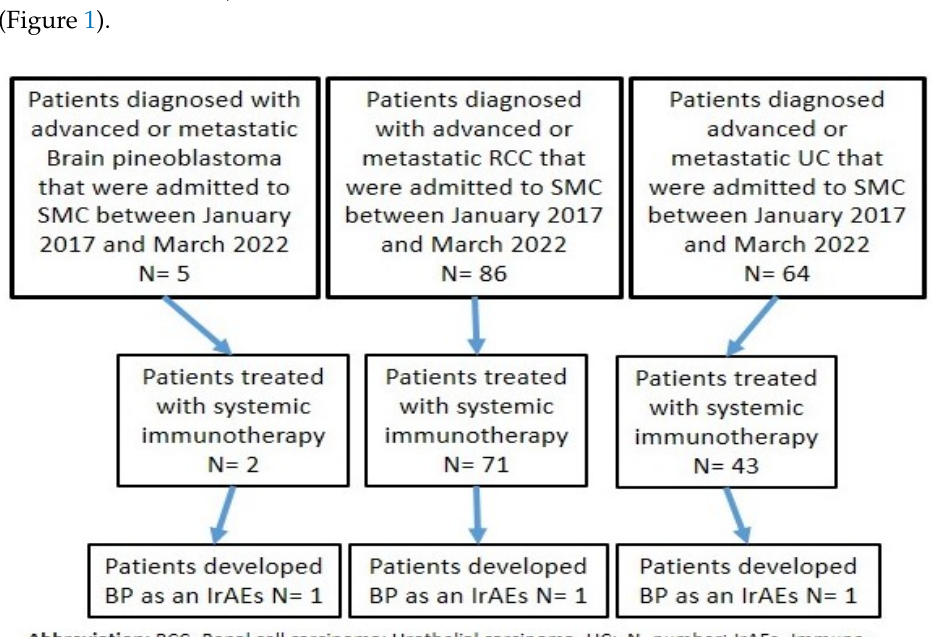
Figure 1. Flow diagram of the single-center, retrospective, observational study of advanced or met- metastatic brain pineoblastoma, renal cell carcinoma, and urothelial astatic brain pineoblastoma, renal cell carcinoma, and urothelial carcinoma.